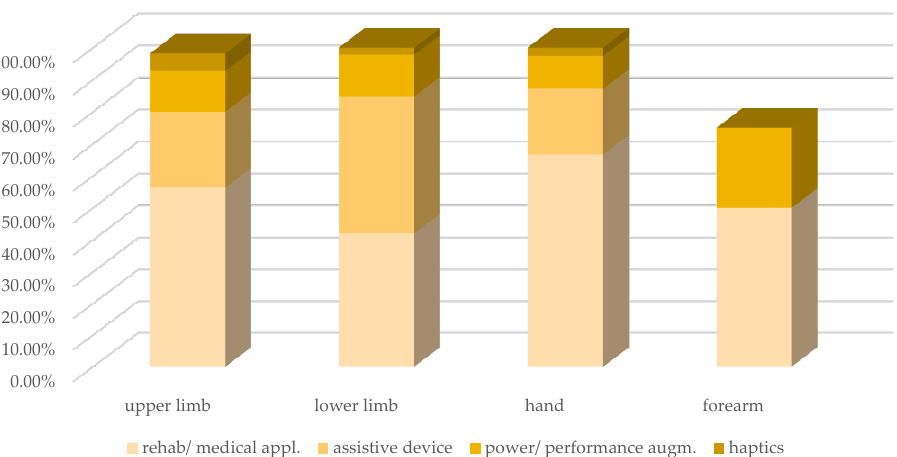
Figure 14. The distribution of exoskeletons purposes for the exoskeletons dedicated to the different anatomical districts. Rehabilitation/medical applications are dominant for ULE (56%), hand (67%) and forearm (50%) devices. For LLE they are almost equally frequent as assistive devices (about 42%).